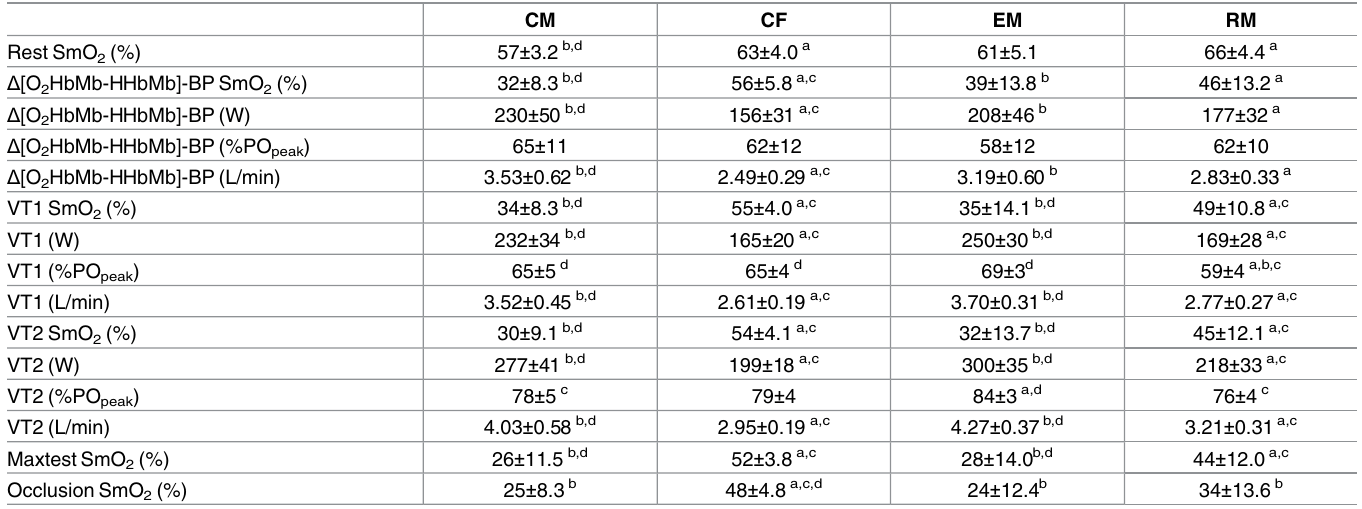
values at the exercise thresholds. 2